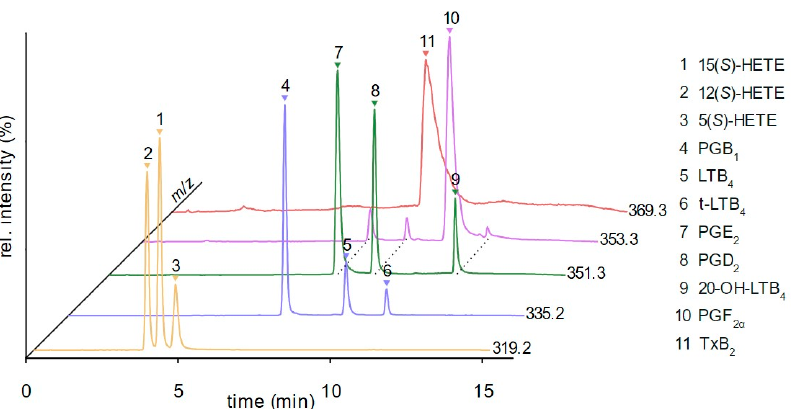
Figure 3. Chromatogram of 11 relevant eicosanoids after method development. Baseline separation of isobaric analytes shown by selected-ion monitoring (SIM) of m / z = 319.2 (5-HETE, 12-HETE, 15-HETE), m / z = 335.2 (PGB 1 , LTB 4 , t-LTB 4 ), m / z = 351.3 (PGE 2 , PGD 2 , 20-OH-LTB 4 ), m / z = 353.3 (PGF 2 α ), and m / z = 369.3 (TxB 2 ), which allows interference-free quantification. Conditions used in the final method: IPA/ACN (7/3) + 0.1% formic acid as modifier, oven temperature = 35 °C, BPR = 100 bar, u = 1.2 mL/min, Lux i-Amylose 3 column.